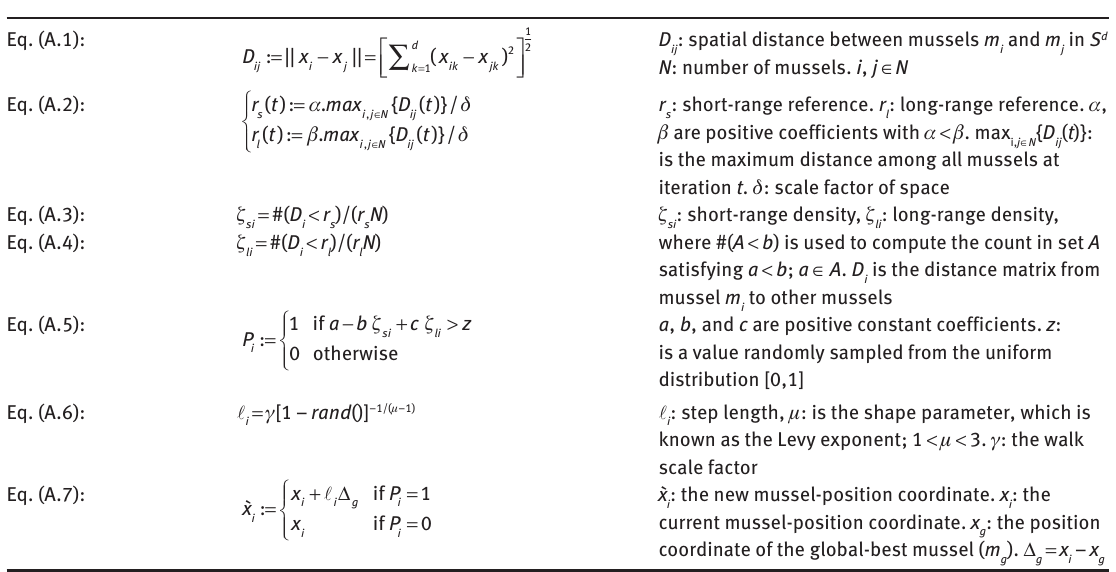
Table 1: List of Equations Used in MWO Algorithm